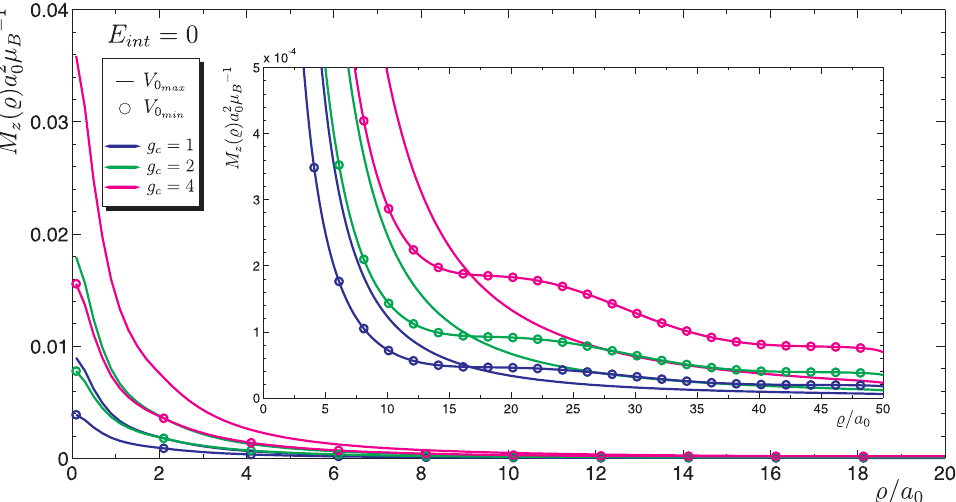
Figure 4. Induced local magnetization M z ( (cid:36) ) as a function of the distance from the impurity center (cid:36)